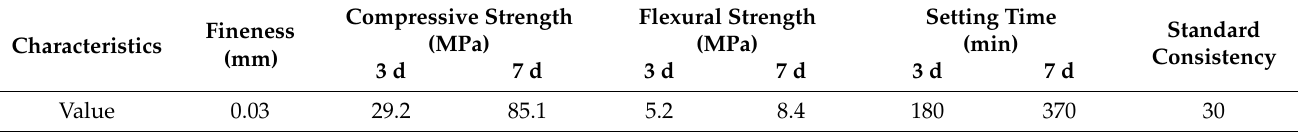
Table 1. Basic performance parameters of cement.